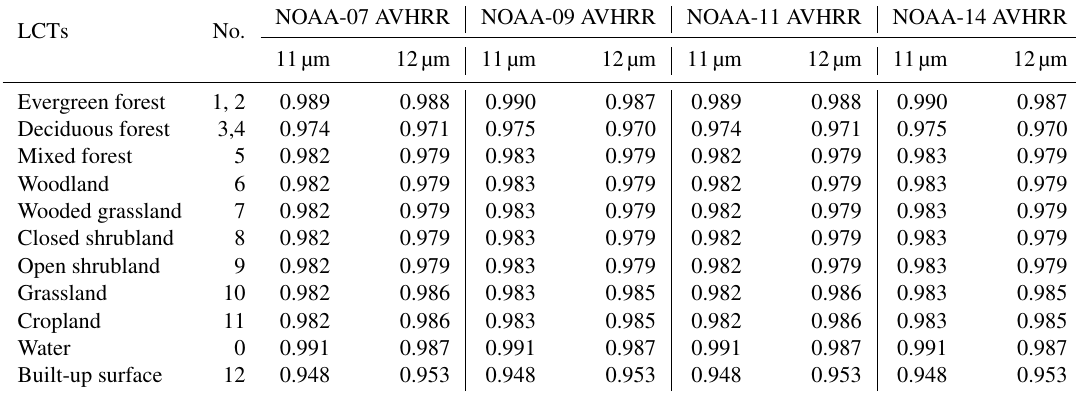
Table 7. Emissivities of different vegetation types, water, and built-up surfaces for the AVHRR channel centered at 11 and 12µm.